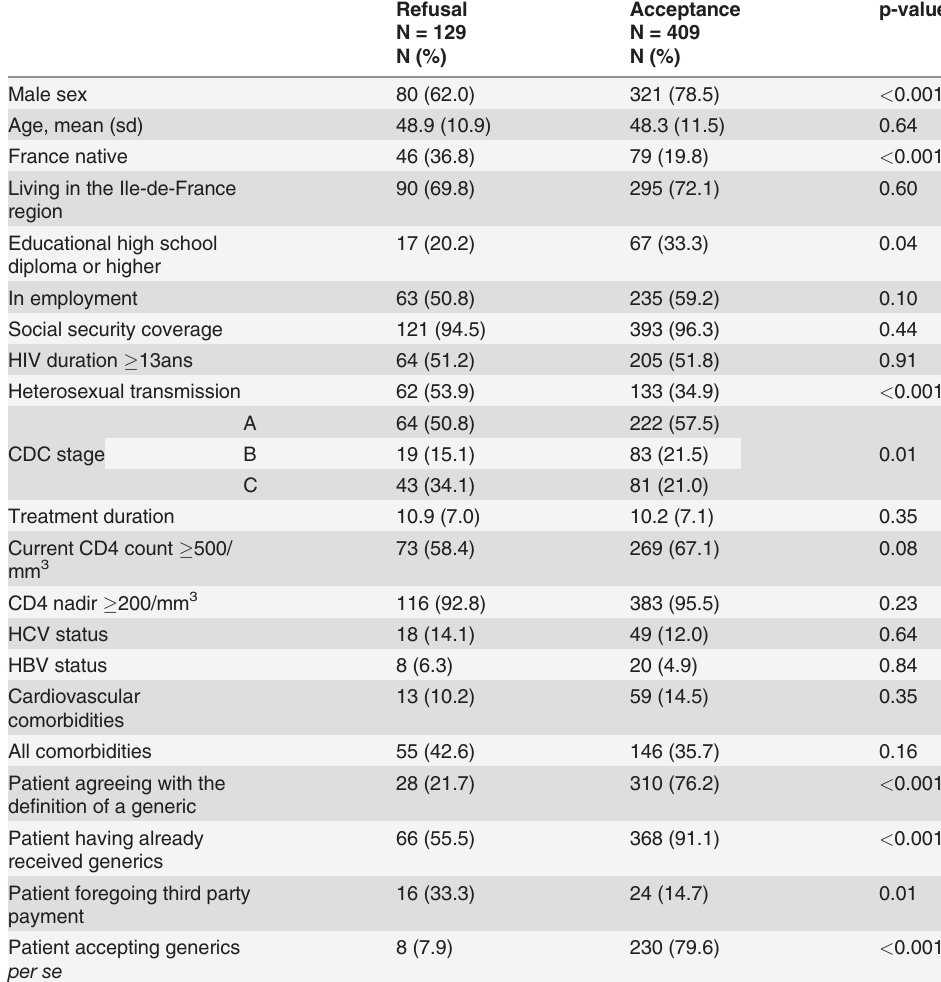
Table 2. Factors associated with acceptance of generics per se by